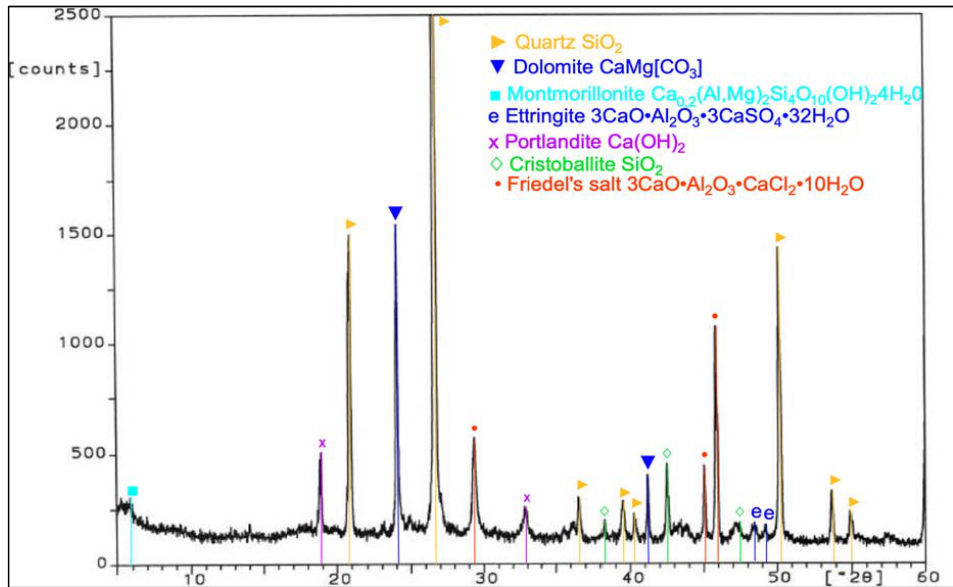
Figure 22. XRD pattern of the ZI mortar (100% CEM I) stored in 1% HCl for 730 days.